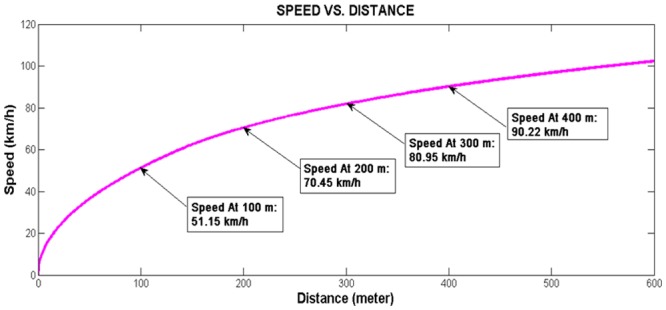
Speed versus distance plot.